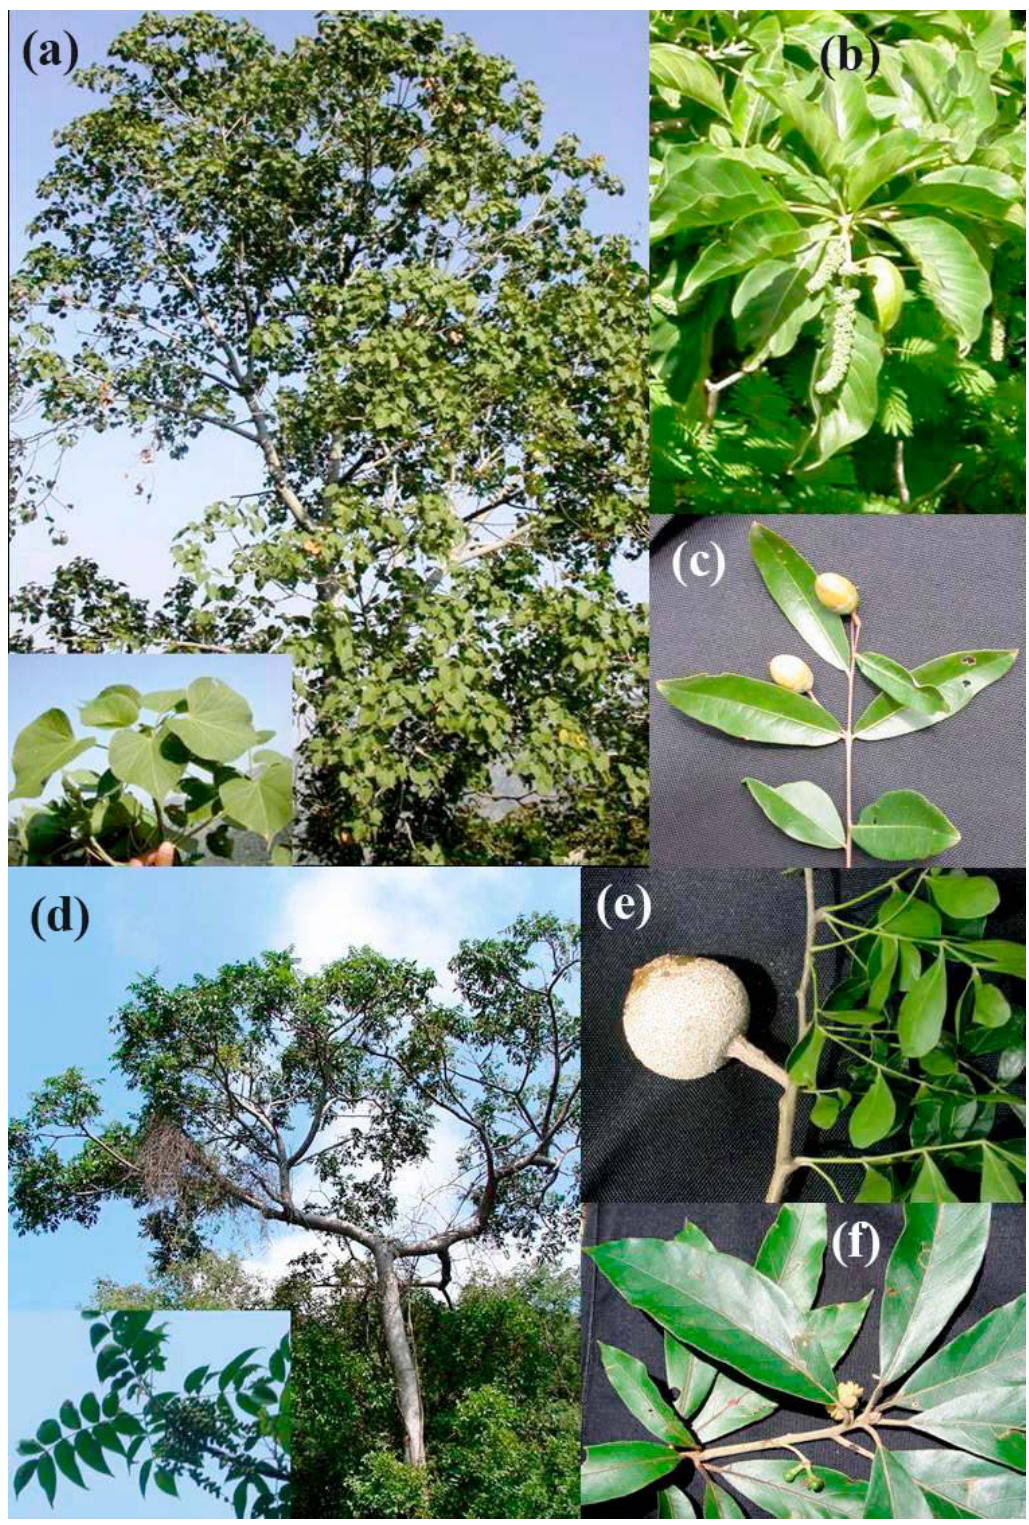
Figure 13. a) Hildegardia populifolia (Sterculiaceae); b) Hymenodictyon orixense (Rubiaceae); c) Lagerstroemia parviflora (Lythraceae); d) Lannea coromandelica (Anacardiaceae); e) Limonia acidissima (Rutaceae); f) Litsea deccanensis (Lauraceae). Photo by L. Arul